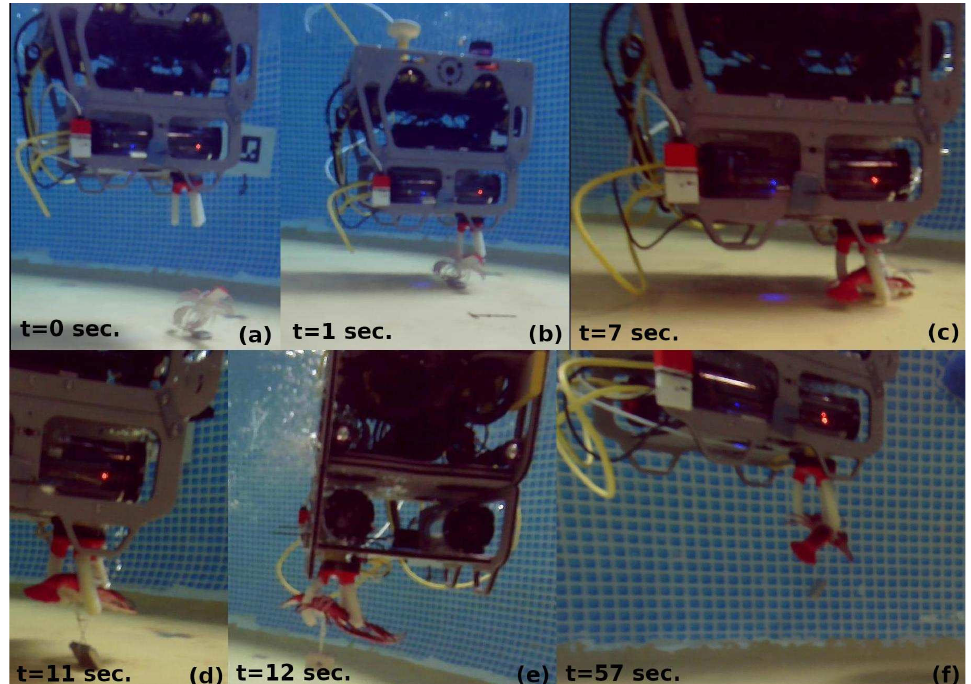
Figure 10. Underwater manipulation using the soft gripper. ( a ) The ROV aligns with the target, ( b ) gets closer to the objective, ( c ) begins the grasping, ( d ) lifts the weight, ( e ) navigates transporting the load, and ( f ) places the target in a different